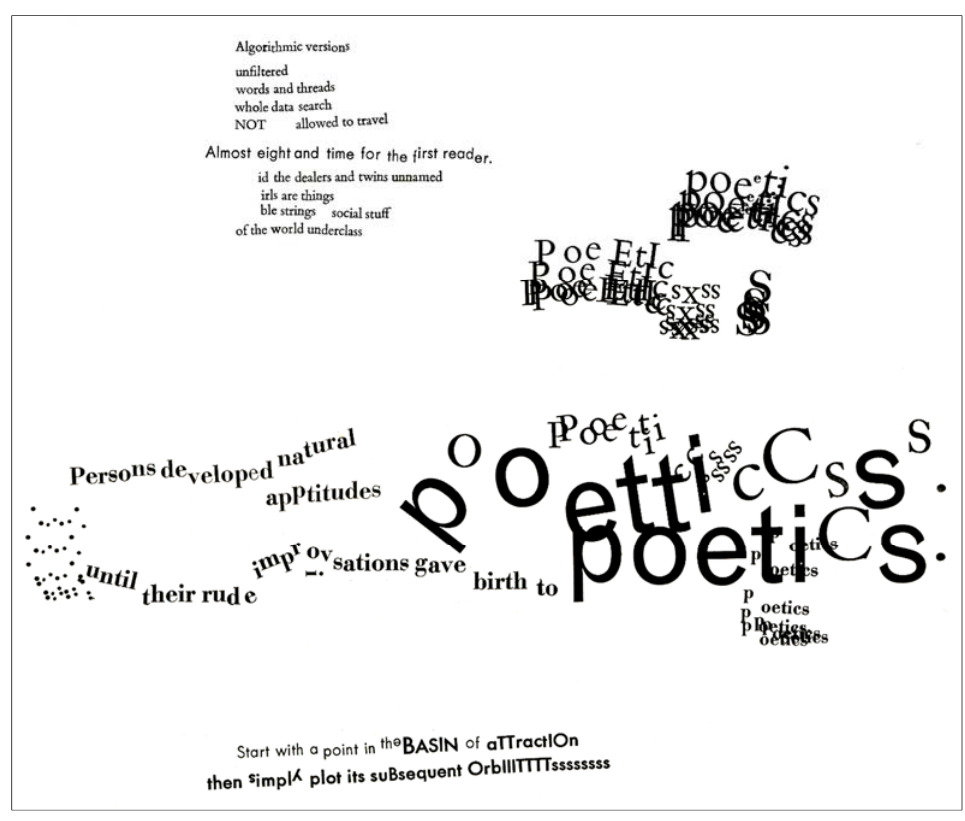
Figure 6. Stochastic